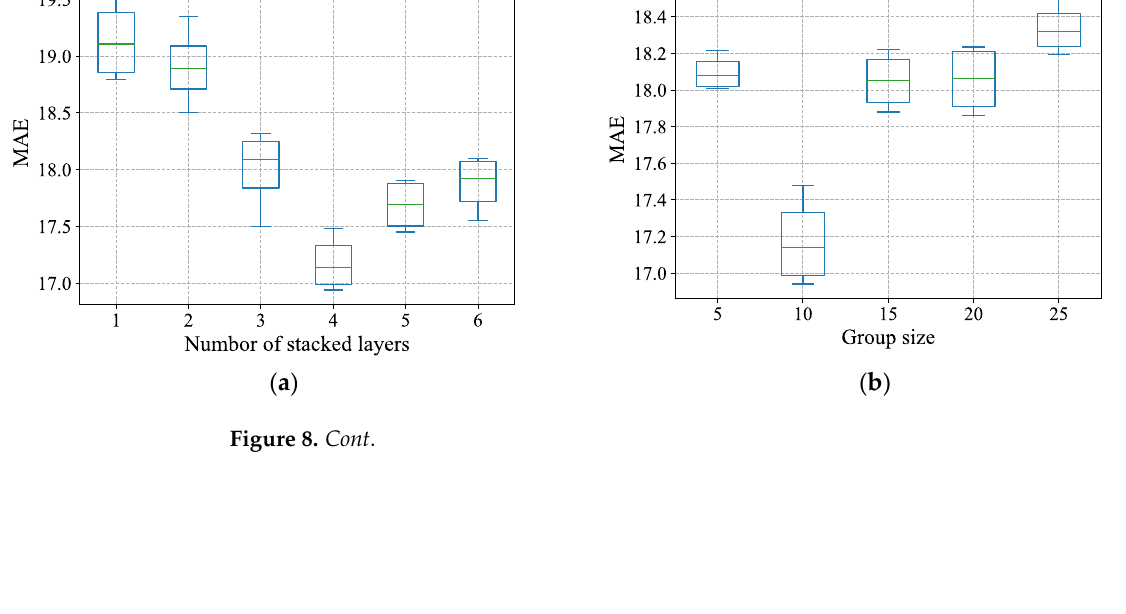
( c ) Figure 8. Parameter study. ( a ) Stacked layers; ( b ) group size; ( c ) model channels. 6. Conclusions In this paper, we propose a new Transformer-based deep learning model, called STCTN, to improve the multivariate time series forecasting. Within STCTN, local-range convolutional attention and group-range convolutional attention are introduced to solve the difficulties of existing methods in capturing complex spatiotemporal dependencies. Local-range convolutional attention mechanism can simultaneously focus on both global and local context temporal dependencies. Group-range convolutional attention mecha- nism is designed to model multiple spatial dependency patterns and also reduce the com- putation and memory complexity. We also proposed continuous positional encoding to link the historical observations and predicted future values in positional encoding and improve prediction performance. Extensive experiments on six real-world datasets show that the proposed method is superior to the existing methods. In the future, we will apply our proposed framework to other spatiotemporal mod- eling tasks, such as trajectory prediction. The local-range convolutional attention and group-range convolutional attention can also be used in other sequence modeling and spatial graph modeling tasks respectively, which are left for future work.